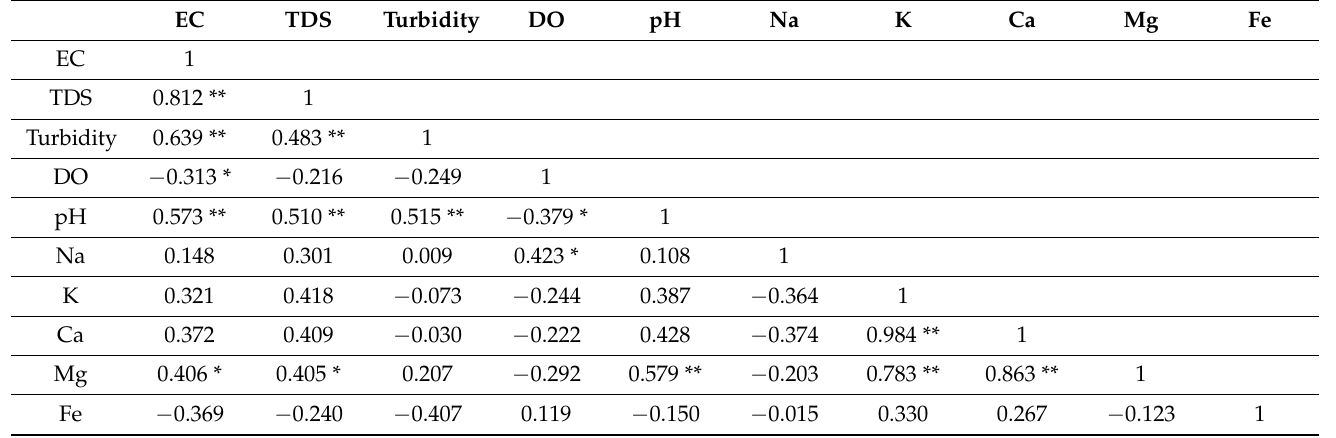
Table 6. Correlation matrix for physicochemical parameters for all